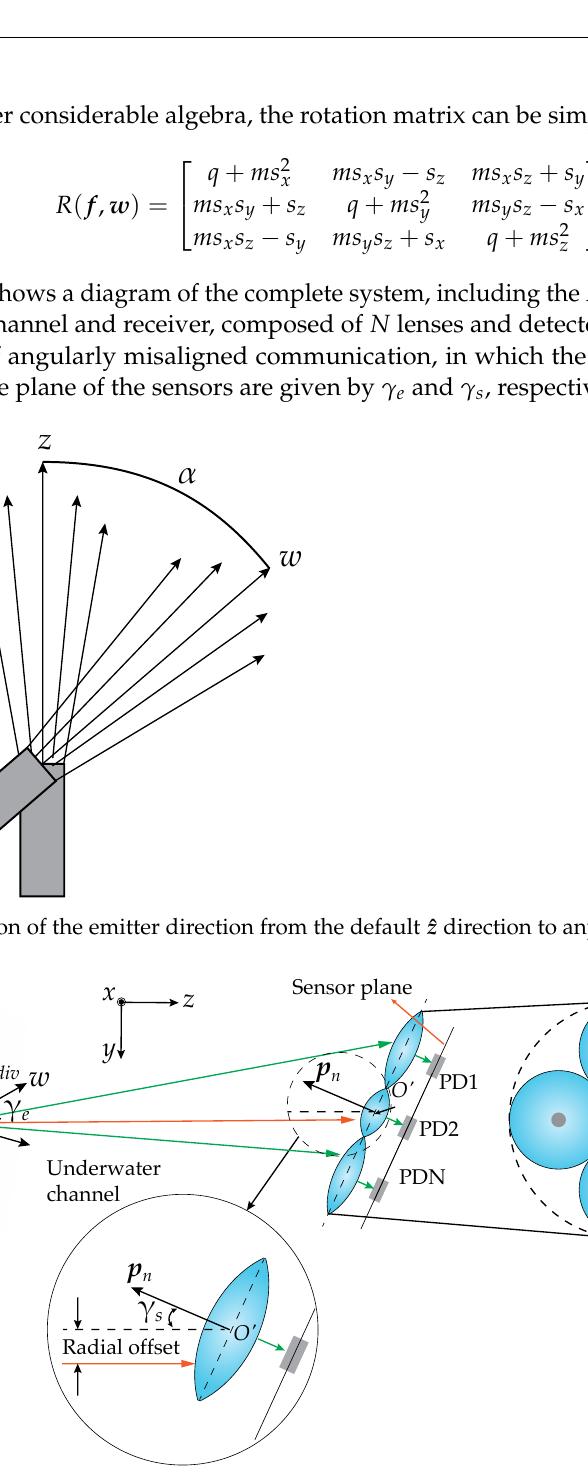
Figure 6. AUV communicating with fixed receiver. Both emitter and receiver are rotated in relation to the z axis by the angles γ e and γ s ,